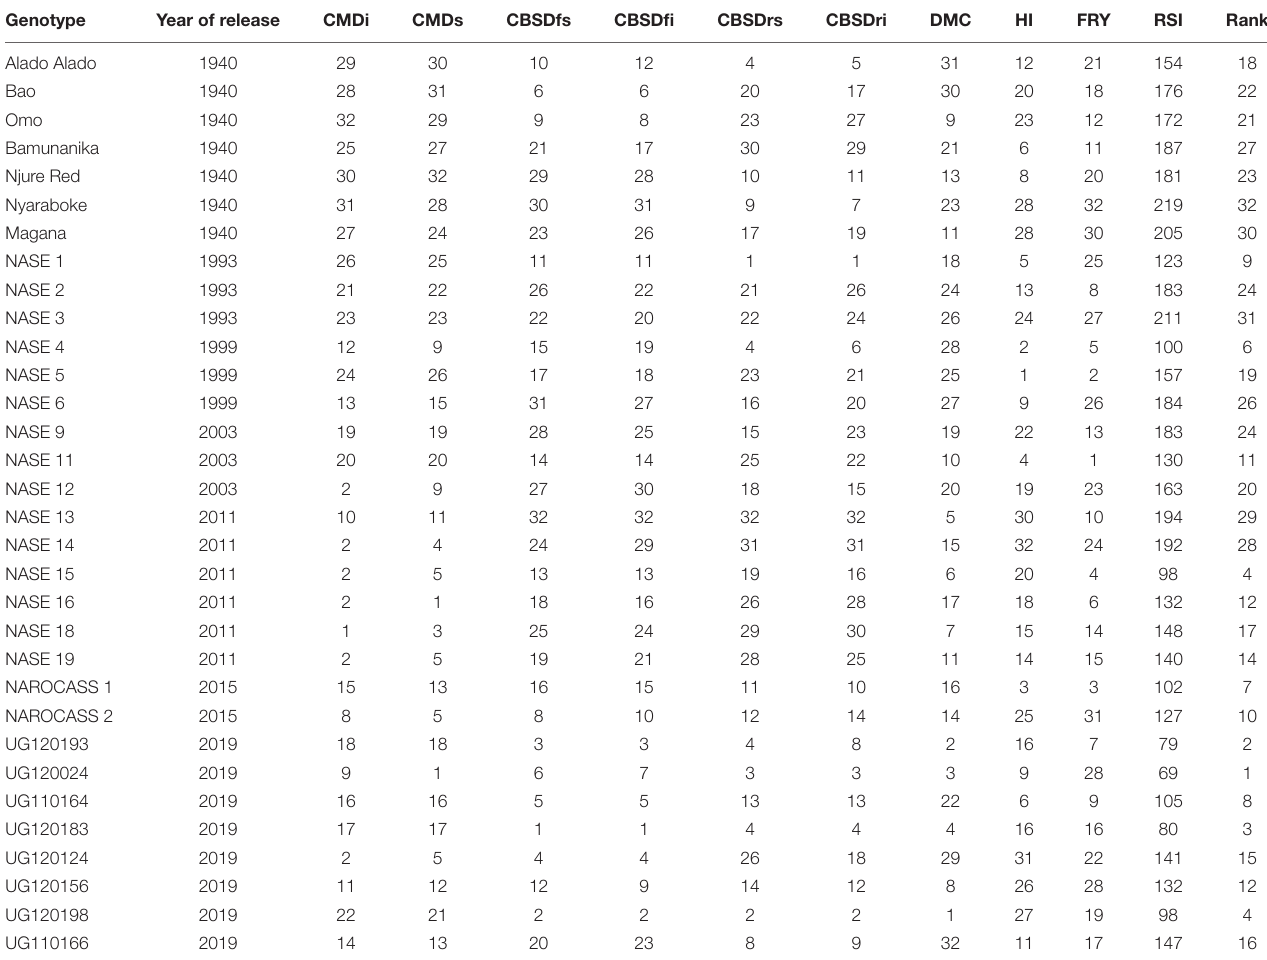
TABLE 3 | Overall performance of clones based on rank summation index. Genotype